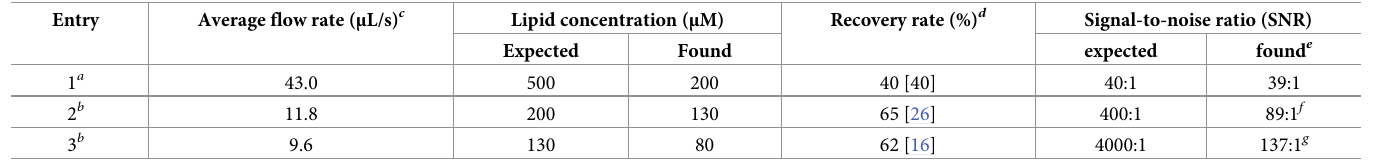
Table 1. Characterization of DOPC/DOPA 7:3 GV retentates obtained by successive dilution-and-microfiltration steps.